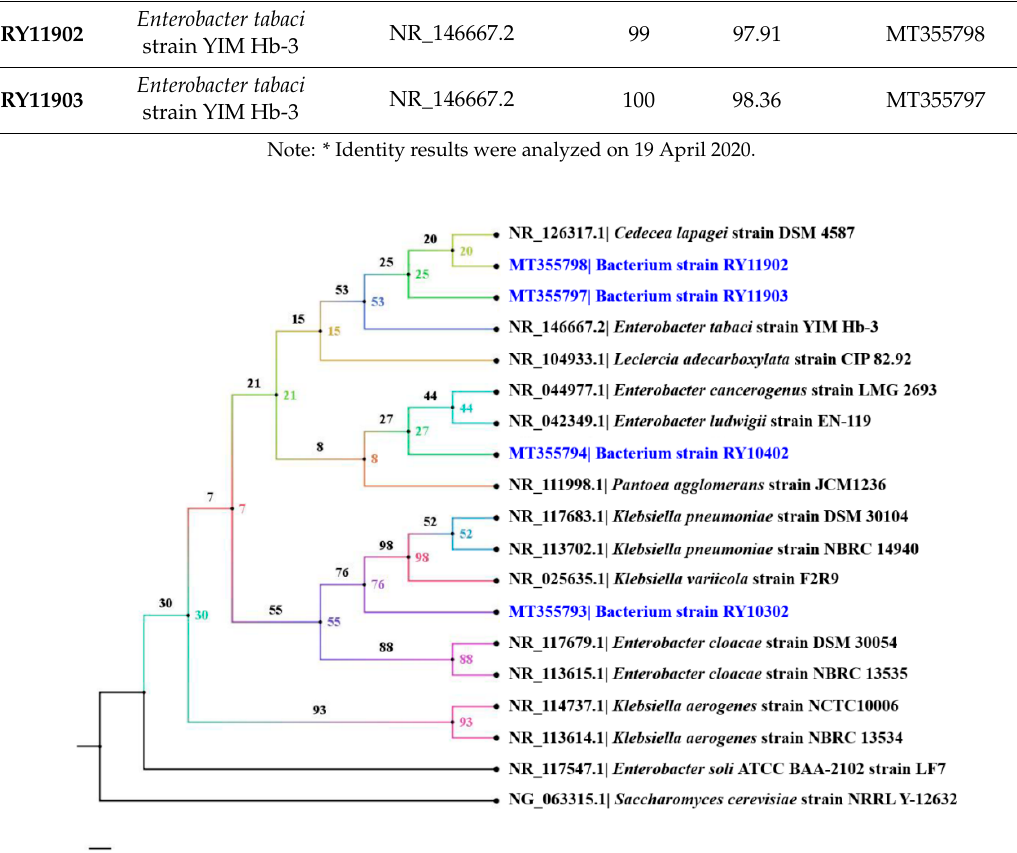
Figure 5. Phylogenetic tree is shown in terms of cladogram of four dye-decolorizing bacteria using the BIONJ algorithm with 100,000 bootstrap replications. The phylogenetic tree was generated by the SeaView program version 5.0.2 and visualized by the FigTree program version 1.4.4.